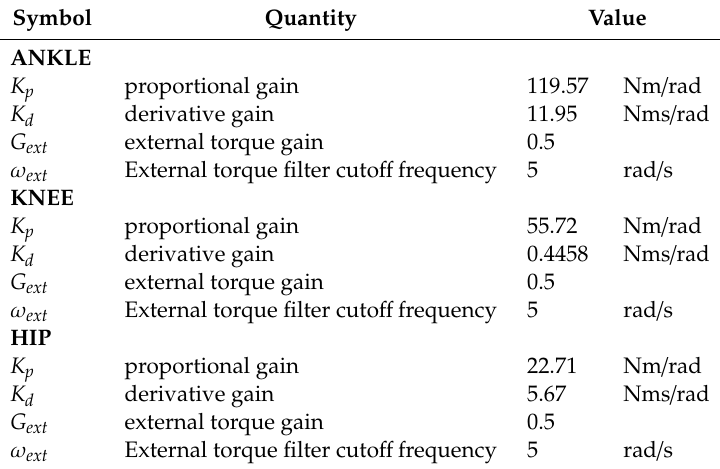
Table 2. Control